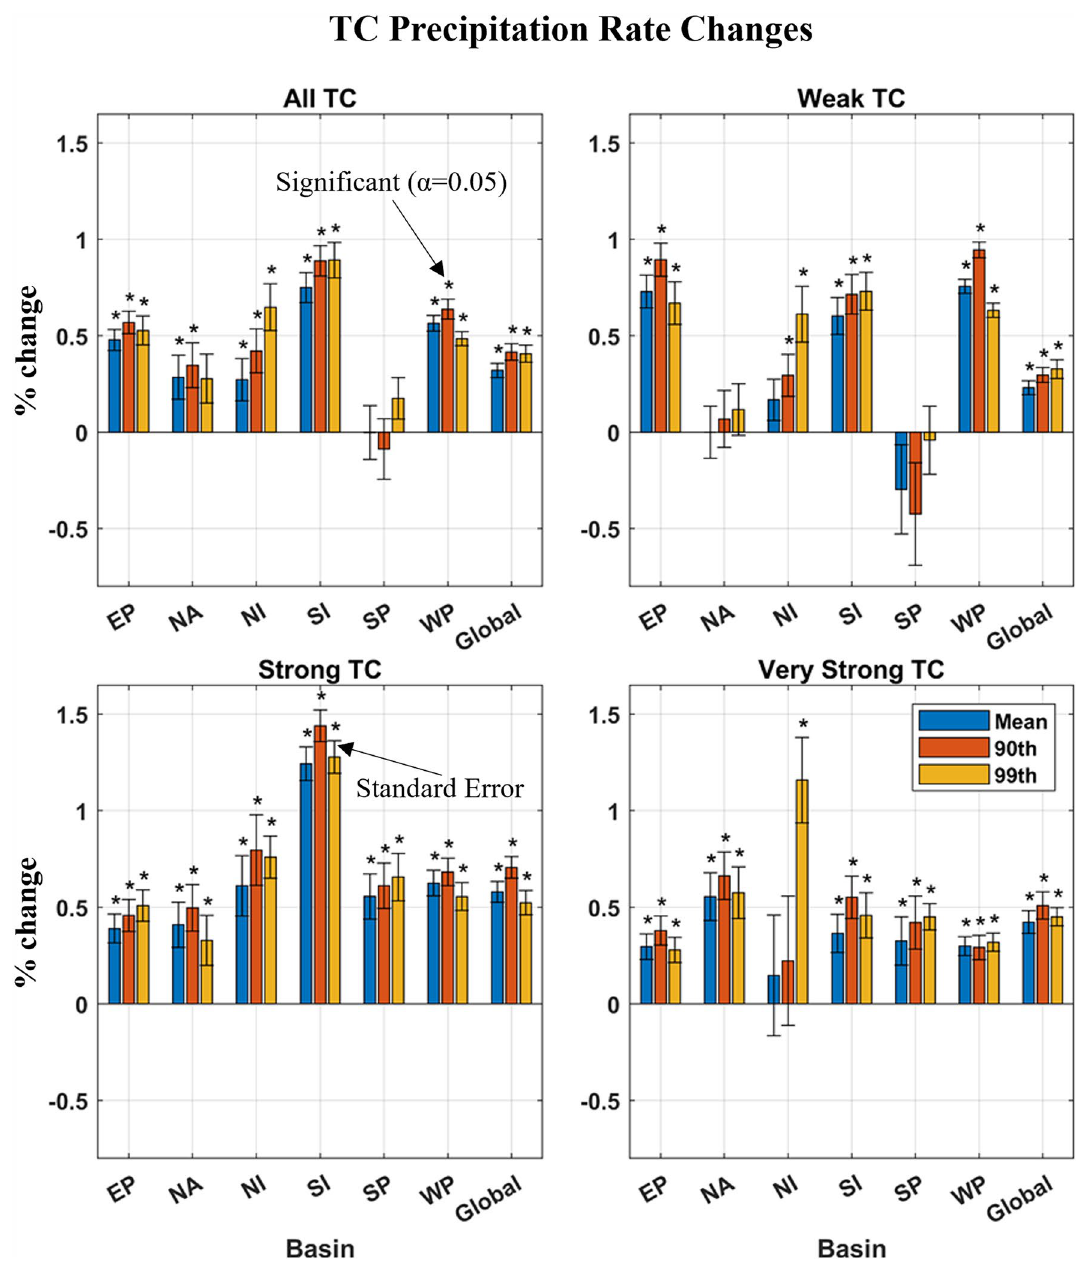
Figure 1. Annual precipitation rate changes of mean and upper percentile precipitation rates by intensity classifications and basins— East Pacific (EP), North Atlantic (NA), North Indian (NI), South Indian (SI), South Pacific (SP), and West Pacific (WP). Rates are calculated from the average year-to-year increase of the fitted linear model. Asterisks represent statistical significance at α = 0.05. During this period, global mean sea surface temperature increased at a rate of 0.13 °C/decade 58 . Knutson et al. 19 identifies warming in the tropics occurs at ~ 75% the rate of global temperatures, translating into a ~ 0.10 °C/decade trend in the pair has a no trend in (cid:31) hV (cid:30) and a positive trend in (cid:31) V (cid:30) , which indicates an increase in volume from an increase in duration rather than changes in precipitation. All other time series with positive trends in (cid:31) V (cid:30) have also experienced an increase in (cid:31) hV (cid:30) (max: 1.24% ± 0.06 per year or 52% over the 40-year period). Simply put, in most cases an increase in TC precipitation volume is at least partially a result of increasing precipitation rates and not solely duration. Increasing trends in Very Strong TC (cid:31) hV (cid:30) in the global and WP categories hint that the corresponding decreasing trends in (cid:31) V (cid:30) are a result of a decrease in event duration. Further analysis into TC durations confirms these results, with decreasing trends of − 0.56 ± 0.11% and − 0.32 ± 0.09% for WP and global Very Strong TC duration, respectively. Other notable negative trends in duration (Table 2) occur in global Strong TCs (− 0.51 ± 0.08%/year) and All TCs in the NI (− 0.43 ± 0.16%/year) and WP (− 0.44 ± 0.12%/year) basins, while increasing trends occur in NA (0.78 ± 0.07%/year) and SI (0.53 ± 0.08%/year). These results are calculated